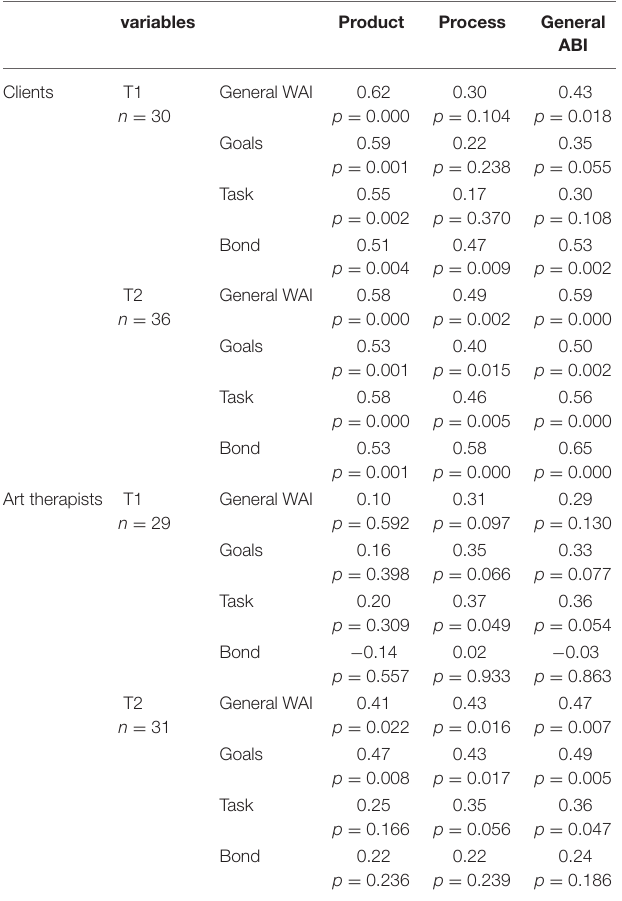
TABLE 3 | Correlations between the therapeutic alliance components (WAI) and client reactions to the artistic experience (ABI). variables Product Process General